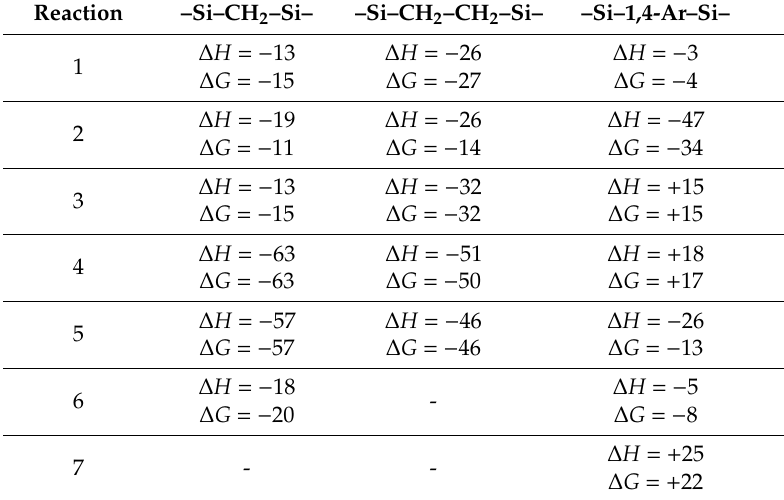
Table 3. Reaction parameters ∆ H and ∆ G in kcal · mol − 1 according to the reaction pathways given in the reaction schemes in Figures 14 and